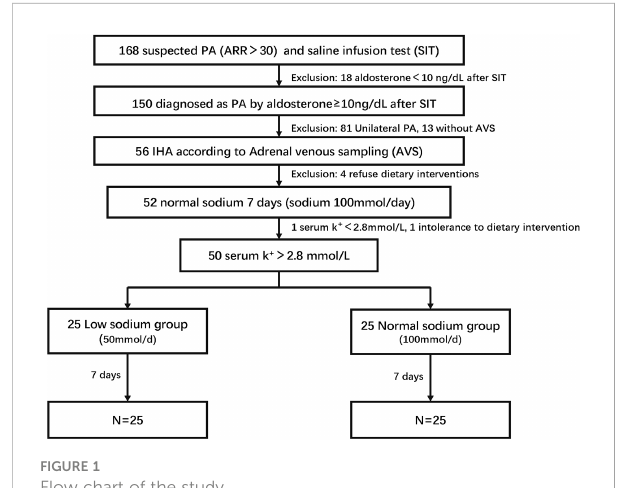
FIGURE 1 Flow chart of the